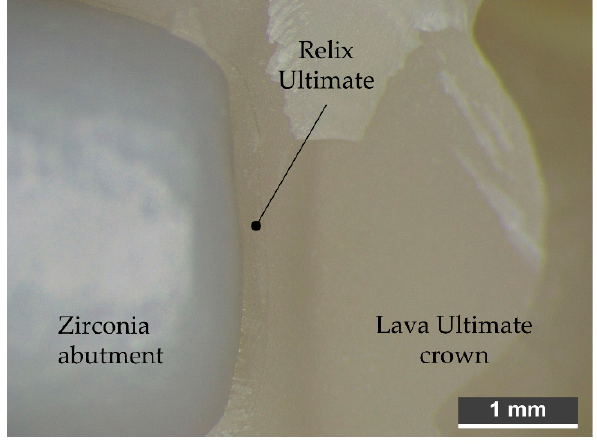
Figure 5. Thin layer of Relix Ultimate material between the Lava Ultimate crown and the zirconia abutment.